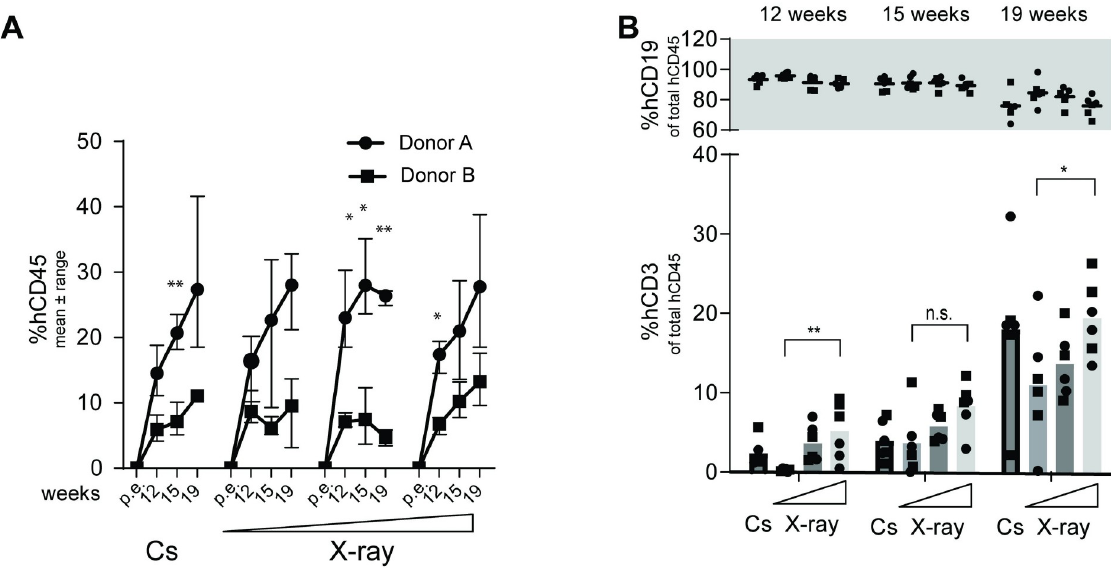
Fig 2. Human chimerization in peripheral blood depicted for each donor as well as for each source of irradiation and dose. (A) Percentage (mean ± range) of peripheral cell chimerization (based on fraction of all WBCs detected) ( ● Donor A, ■ Donor B). Statistical significant differences between donors for each time points were calculated using multiple t-tests with Holm-Sidaks correction for multiple comparisons. Asterisks are depicted above significant differences. (B) Percentage (mean ± range) of either peripheral B cells (top panel) or T cells (bottom panel) (based on fraction of WBCs that express human CD45) presented as a mean of all 6 mice in each radiation group, the two donors combined ( ● Donor A, ■ Donor B). Relevant statistical comparisons between irradiation groups using Mann-Whitney U tests are depicted above